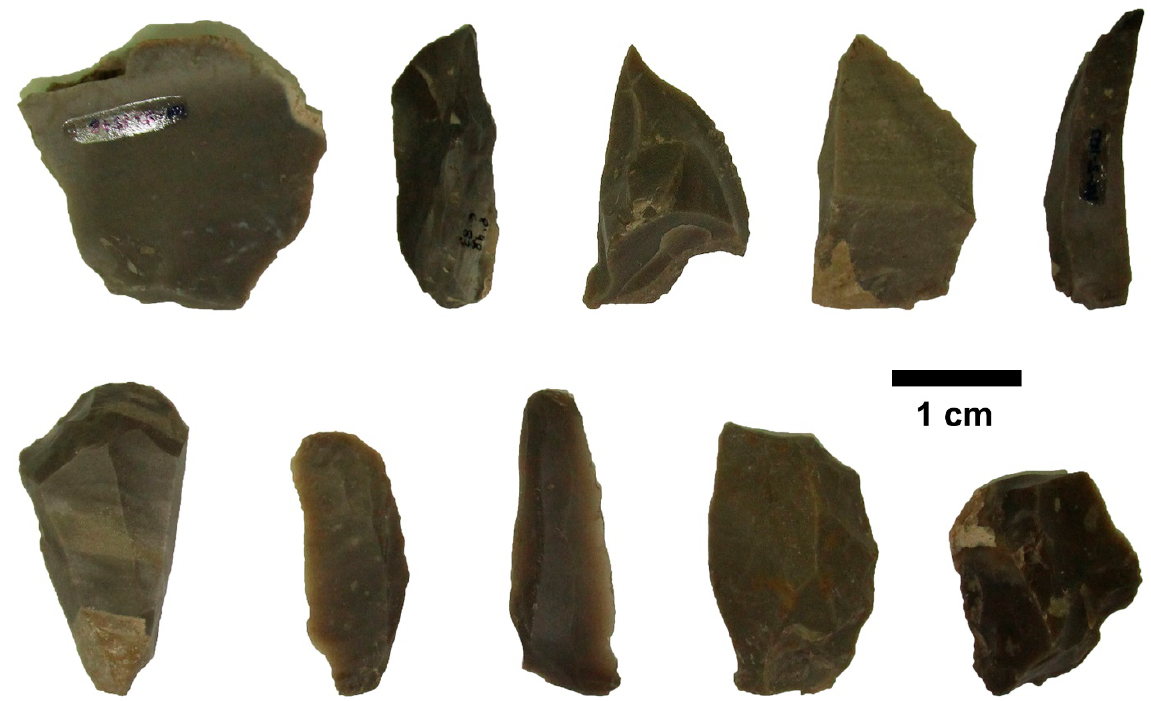
Figure 12. Grey flint